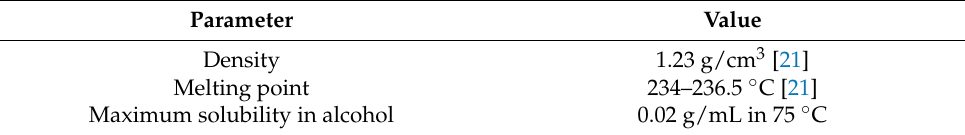
Table 2. Caffeine properties.